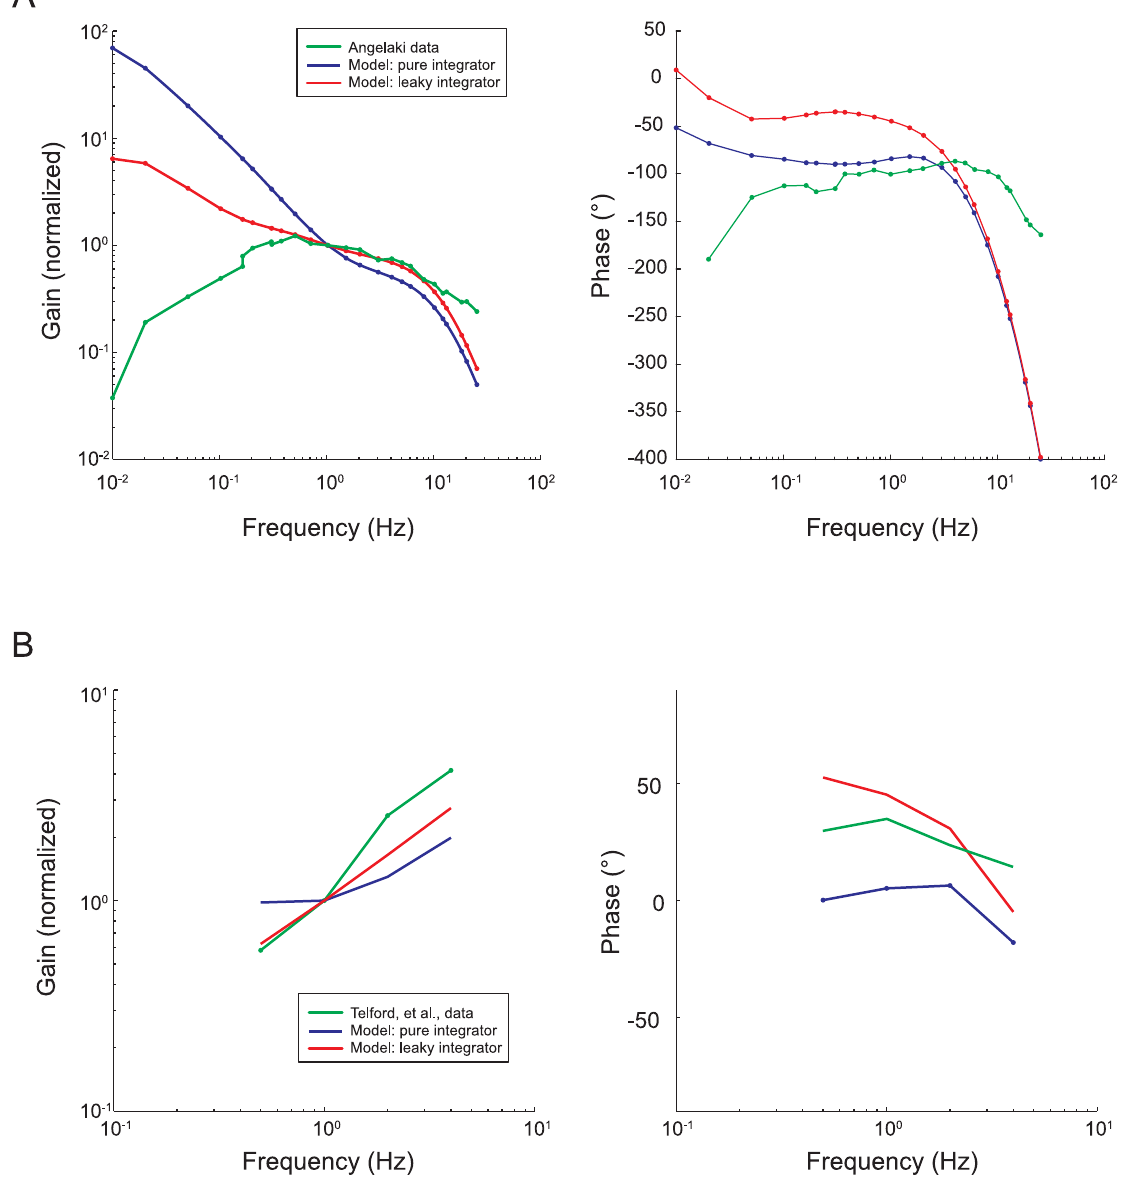
Figure 10. Frequency response simulations of the Simulink model, compared to published data. Data values from the two studies were extracted from published figures (as noted), using a public-domain program (G3Data). Model simulations were run for inputs at each of the frequencies of the respective data set. The amplitude and phase of the model output were computed using a sinusoidal fitting technique [54]. To account for differences in absolute scaling (e.g., different effective fixation distances), the amplitudes of both the simulated and actual data were normalized to give a response gain of unity at 1 Hz. In each case, the green trace shows the actual data extracted from the published figure, the blue trace shows the model response when the tVOR integrator is representated by a pure integrator, and the red trace the model response with a leaky integrator ( t =10 s). a . Comparison of model responses to data of Angelaki [see Figure 9 of reference 41]. Consistent with the published data, response amplitudes are presented as the ratio of eye velocity to head acceleration (equal amplitude head accelerations were used as the model input in this case), and response phases similarly represent the phase of eye velocity relative to head acceleration. Phases differ from the published data by 180 u , because 180 u was added to the measured data by Angelaki for illustration purposes (see figure legend). b . Comparison of model responses to data of Telford, et al. [see Figure 12 of reference 40]. In this case, response gains and phases are determined relative to translational head